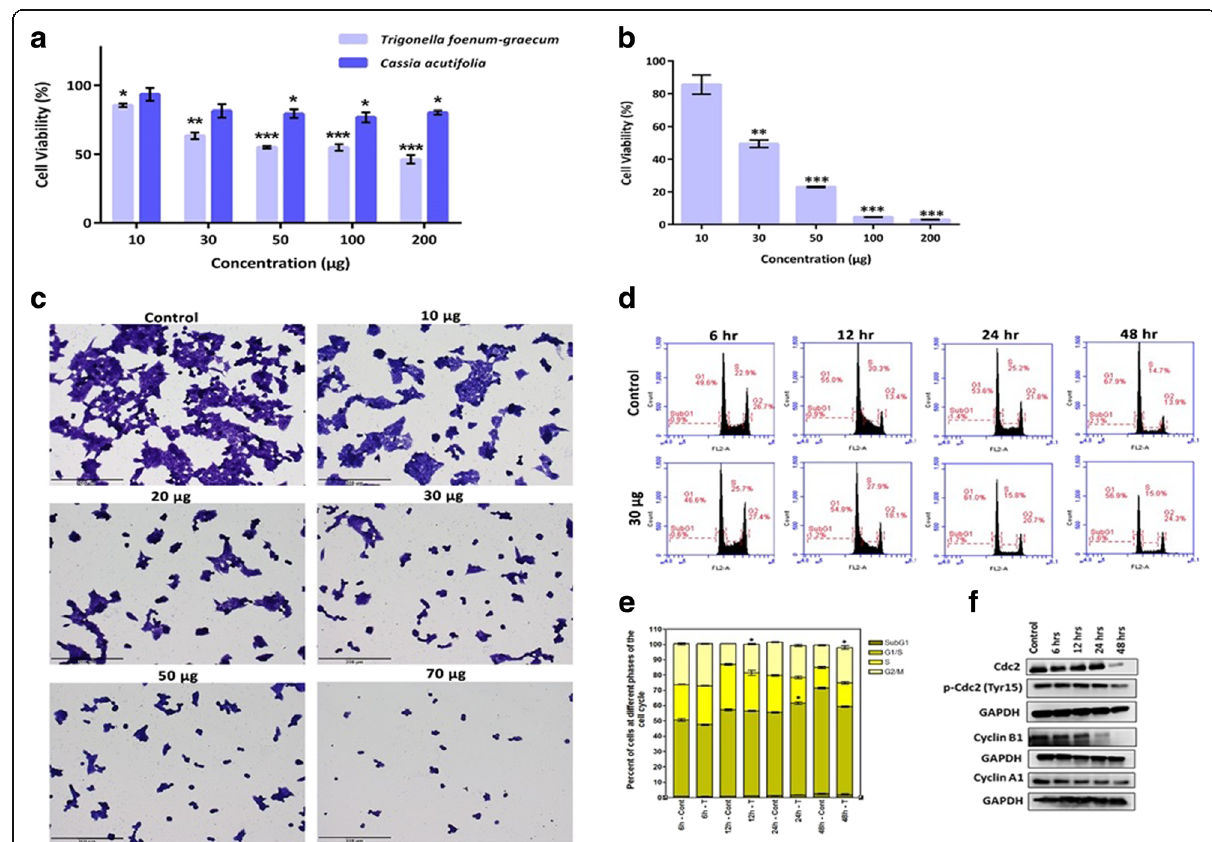
Fig. 5 Assessment of the cytotoxic effects of Trigonella foenum-graecum (Helba), Cassia acutifolia (Holoul), and Rhazya stricta (Harmal) extracts on HepG2 in vitro. a MTT assay results of HepG2 cells viability after treatment with increasing concentrations of Helba and Holoul for 24 h. * P < 0.05, ** P < 0.001, *** P < 0.0001 b MTT assay results of HepG2 cells viability after treatment with increasing concentrations of R. stricta extract for 24 h. * P < 0.05, ** P < 0.001, *** P < 0.0001 c Assessment of morphological changes of HepG2 cells after treatment with increasing concentrations of R. stricta extract for 24 h. Cells were fixed and stained with crystal violet (scale bar = 200 μ m). d Cell cycle progression of HepG2 cells after treatment with R. stricta extract at a dose of 30 μ g over a period of 48 h. e Quantitative distribution of HepG2 cells in different phases of the cell cycle at different time intervals (* P < 0.05) f Immunoblot analysis of cell cycle regulatory proteins in HepG2 cells after treatment with R. stricta extract at a dose of 30 μ g over a period of 48